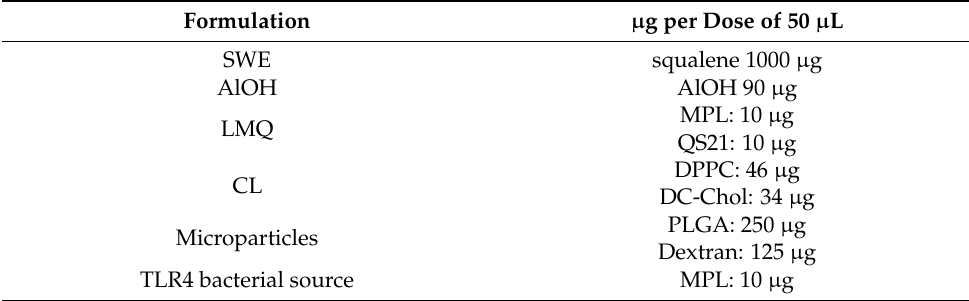
Table 3. Amount of compounds used in the extrinsic adjuvant